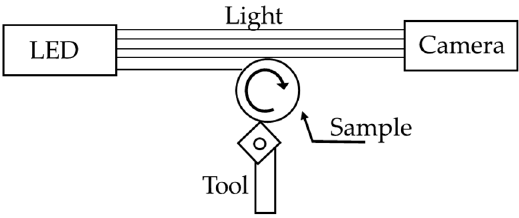
Figure 1. Simplified scheme of the conceived backlit vision-based measurement instrument where a cylindric bar is turned between a camera and a light source and surface roughness is measured in-line during production.